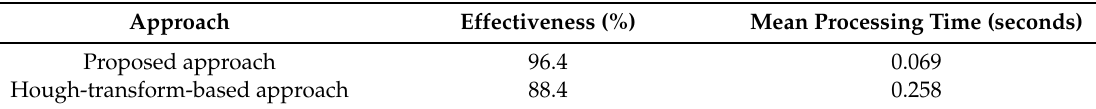
Table 4. Detection of the central crop row. Performance of the proposed approach and an approach that is based on the Hough transform.